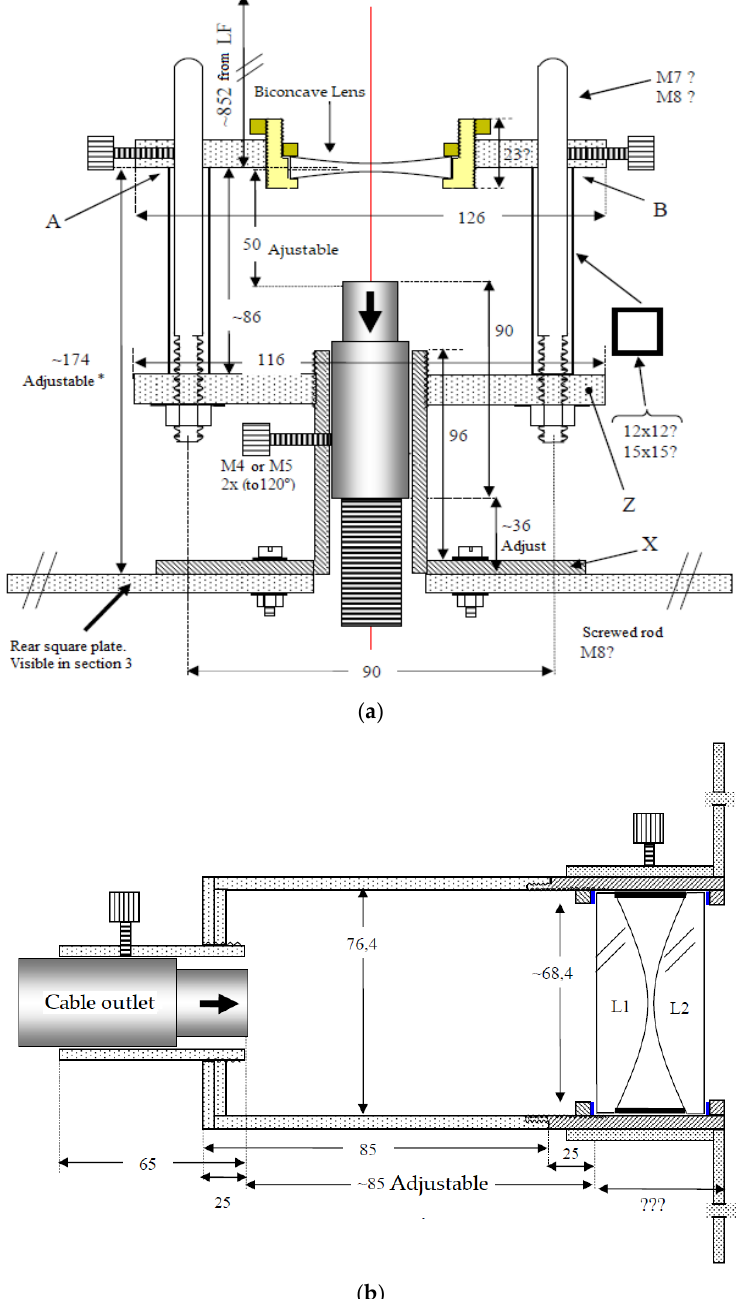
Figure 3. ( a ) Design of a diverging system to be used at the entrance/inlet of the optical fiber bundle/cable [15]; ( b ) design of a converging system to be used at the end/outlet of the optical fiber bundle/cable [15]; all dimensions in